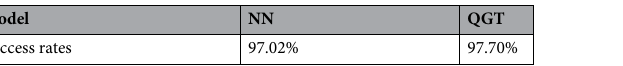
Table 3. Comparison of the success rates in NN model and QGT model. Success rates: the percentage of correct predictions among all test